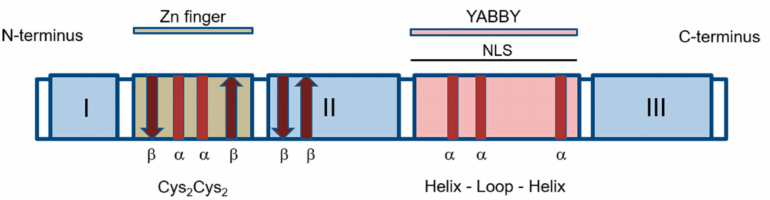
Figure 2. Structure of YABBY proteins. YABBY transcription factors are characterized by two highly conserved domains, the N-terminal Cys2/Cys2 zinc-finger and the C-terminal DNA-binding YABBY domain representing a helix-loop-helix motif with similarity to high mobility group domain [12]. Red rectangles labeled α and brown arrows labeled β represent α -helices and β -sheets, respec- tively. The nuclear localization signal (NLS) is located within the YABBY domain and has a complex nature, requiring the action of multiple amino acids within the YABBY domain and probably ho- modimerization of the proteins [40]. I–III, regions of variable amino acid sequences. Modified based on